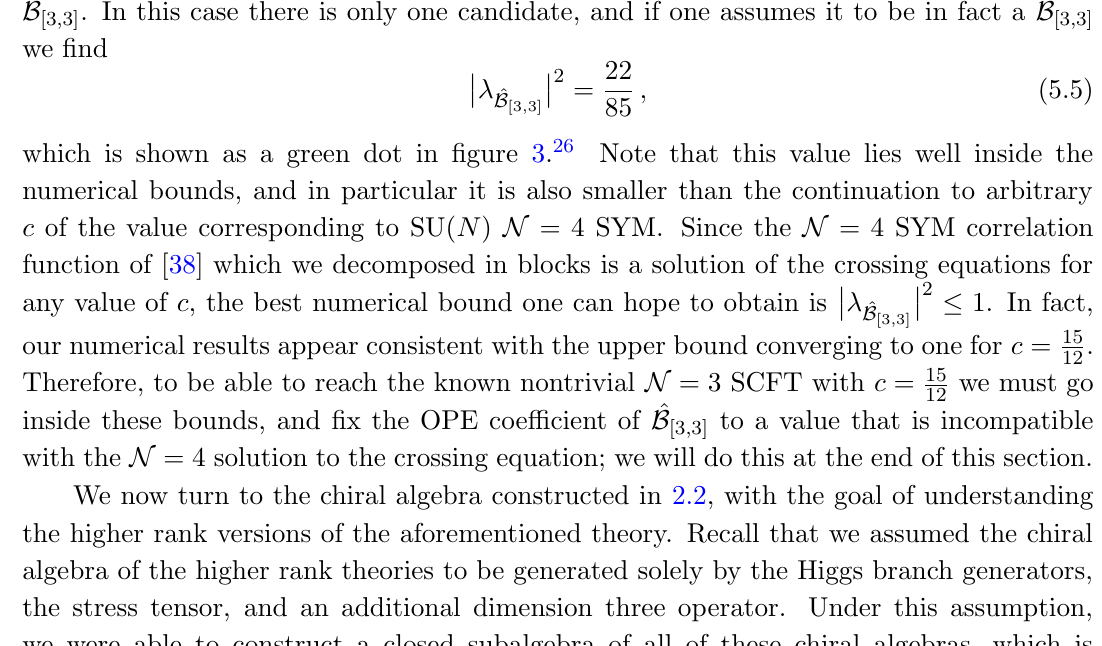
versus the inverse central charge [3 ; 3] (cid:25) 2 : 73 and c (cid:0) 1 = 24 (cid:25) 1 : 84 11 13